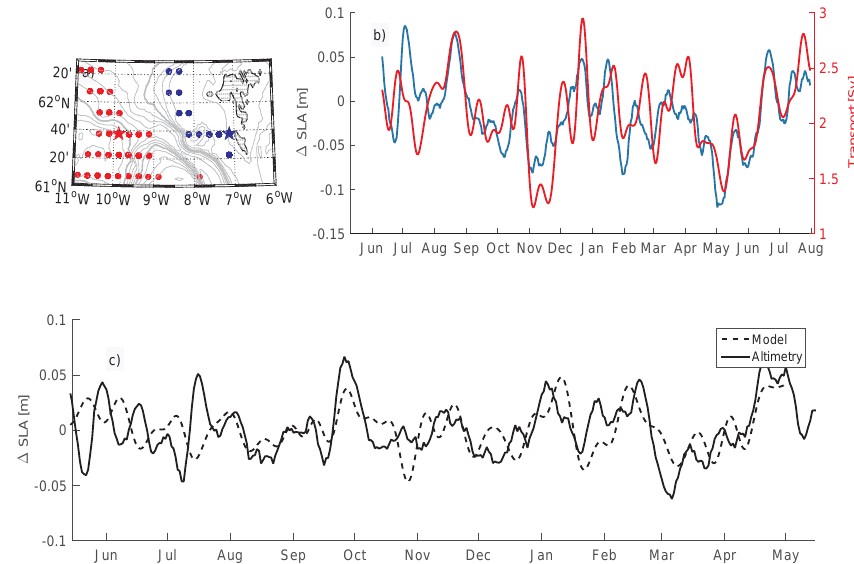
Figure 9. (a) Map over the study region showing the grid points from the AVISO gridded data set of sea level anomalies (SLA) from 2012 to 2013 where the difference in SLA ( (cid:49) SLA) between any of the blue circles and (at least) one of the red circles correlates positively with the transport across the sill with a correlation coefficient r > 0 . 65. The stars indicate the grid point combination with the highest correlation ( r = 0 . 71) and the corresponding time series of (cid:49) SLA is shown in ( b , blue line) together with the transport across the sill from FB (red line). All data are 14-day low passed filtered. (c) (cid:49) SLA between the points marked with a star in (a) from the numerical model (dashed, black line) and from AVISO (black line) in 2008–2009. The data are band passed (14–120